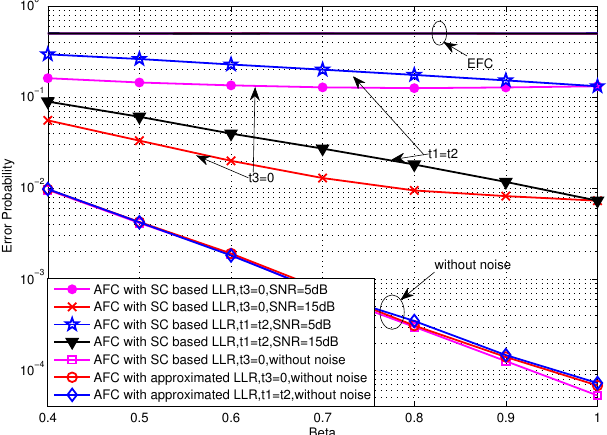
Figure 7. Error probabilities at the AFC and EFC as functions of various β for snr L = 5 dB over high SNR